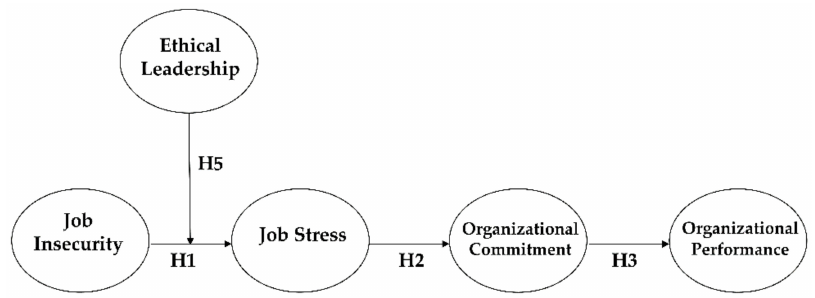
Figure 1. Theoretical